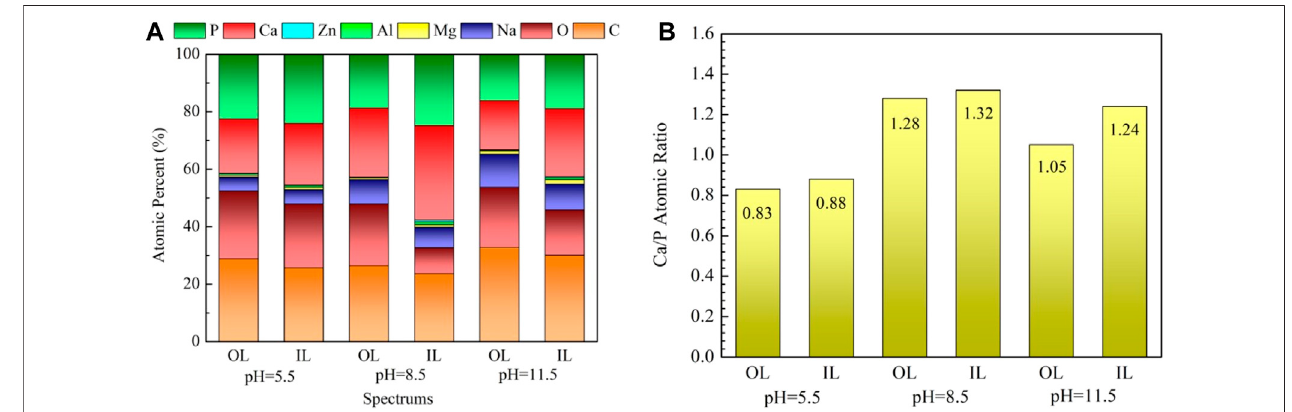
FIGURE 4 | EDX results of the marked spots in Figure 3 : (A) EDX spectra, (B) Ca/P atomic ratio.